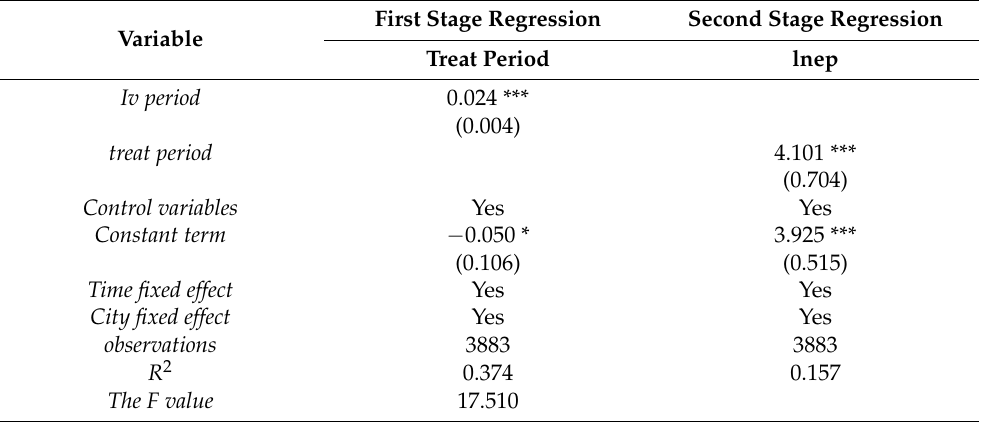
Table 6. Energy trading and environmental performance: estimation of instrumental variables.